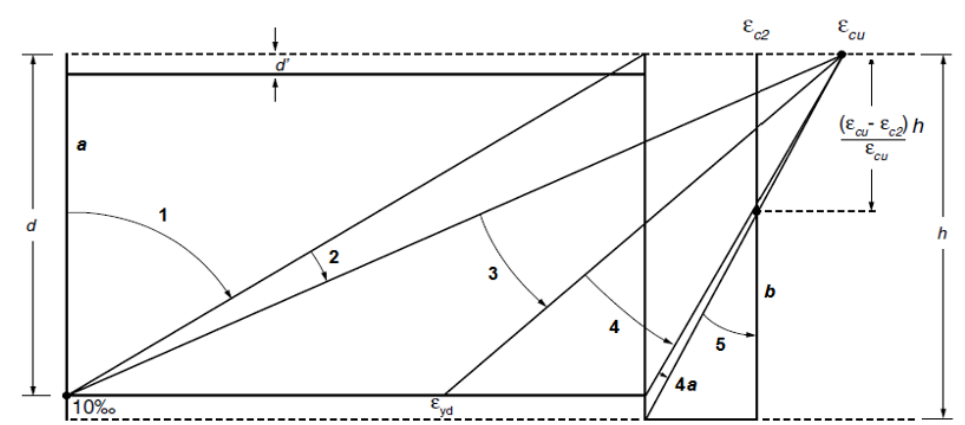
Figure 3. Strain domains in the ultimate limit state. Source: Adapted from the ABNT NBR 6118: 2014